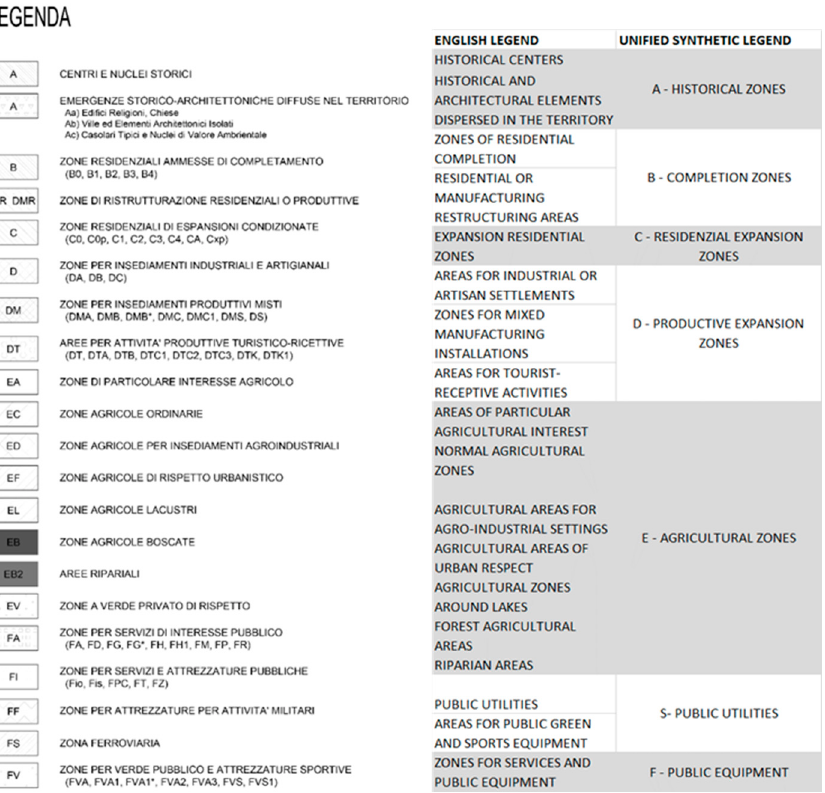
Figure 11. An example from a municipal regulatory plan from 2011—from the original legend (in Italian language) to the unified legend for PTM (Ref. Ministerial Decree 1444/68).